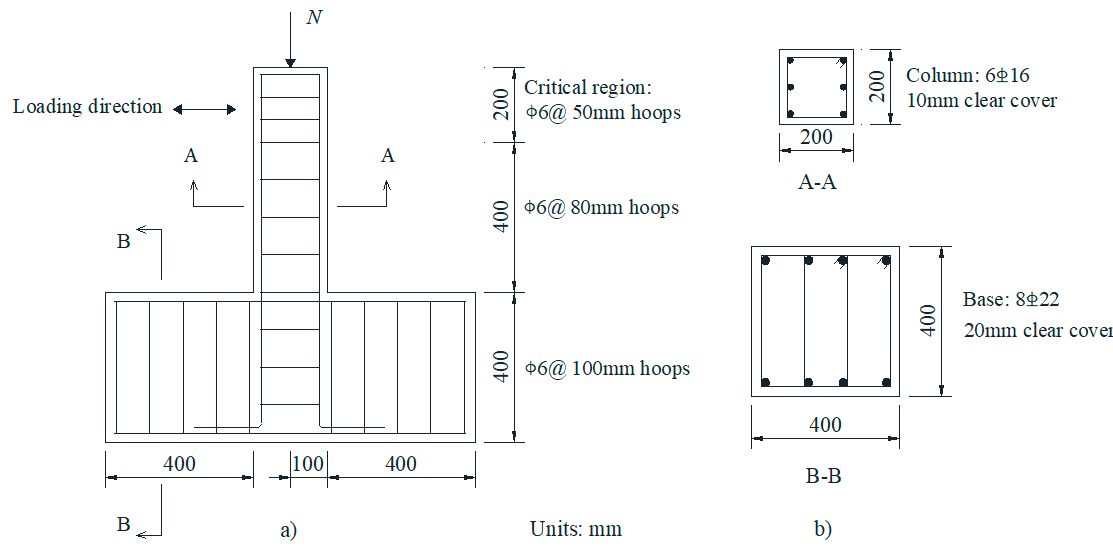
Table 1. Design parameters of specimens.